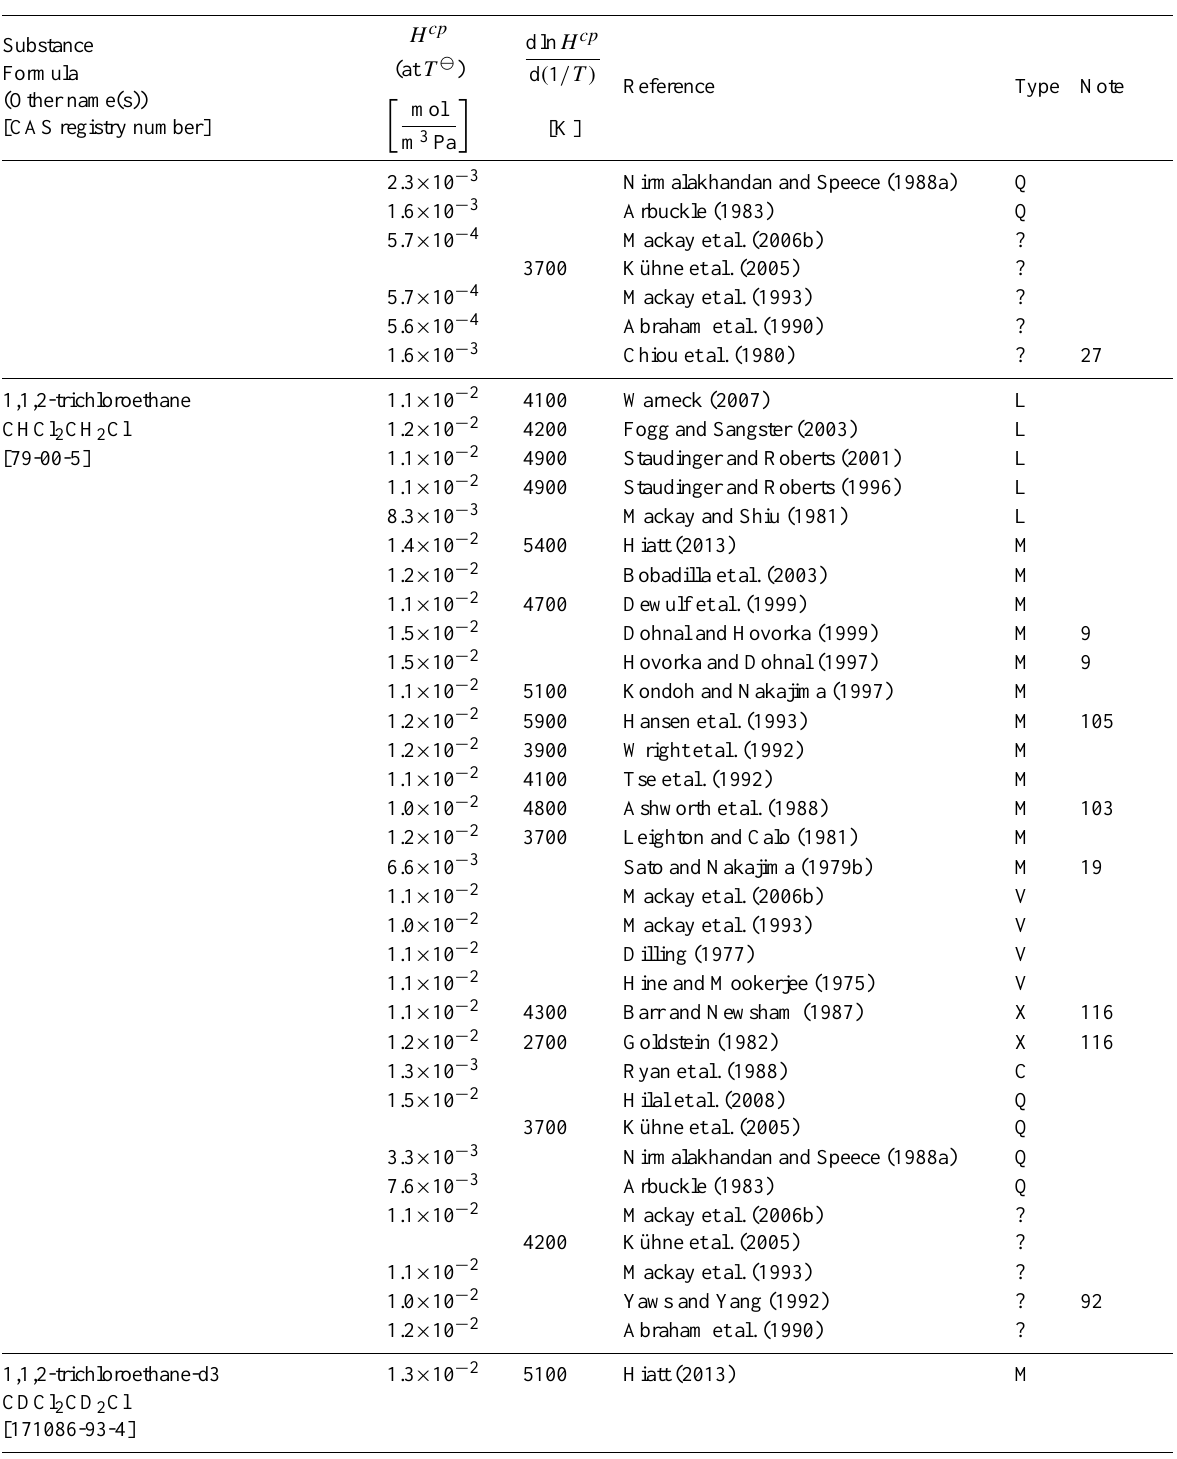
Table 6: Henry’s law constants for water as solvent